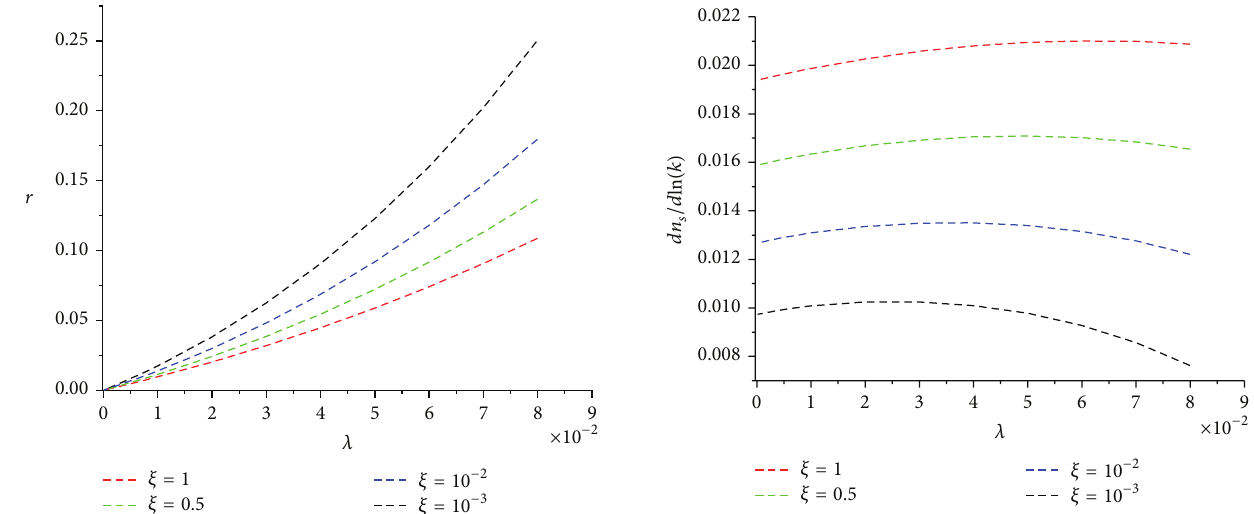
Figure 5: 𝑟 versus 𝜆 for different values of 𝜉 for 𝑇 = 5 × 10 58 GeV 4 and 𝑁 = 60 .